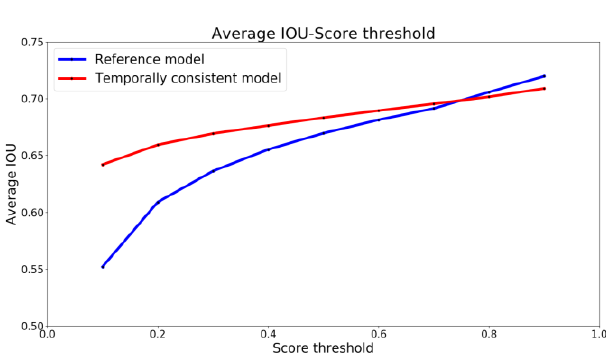
Figure 4 Average IOU-Score threshold graphs of two